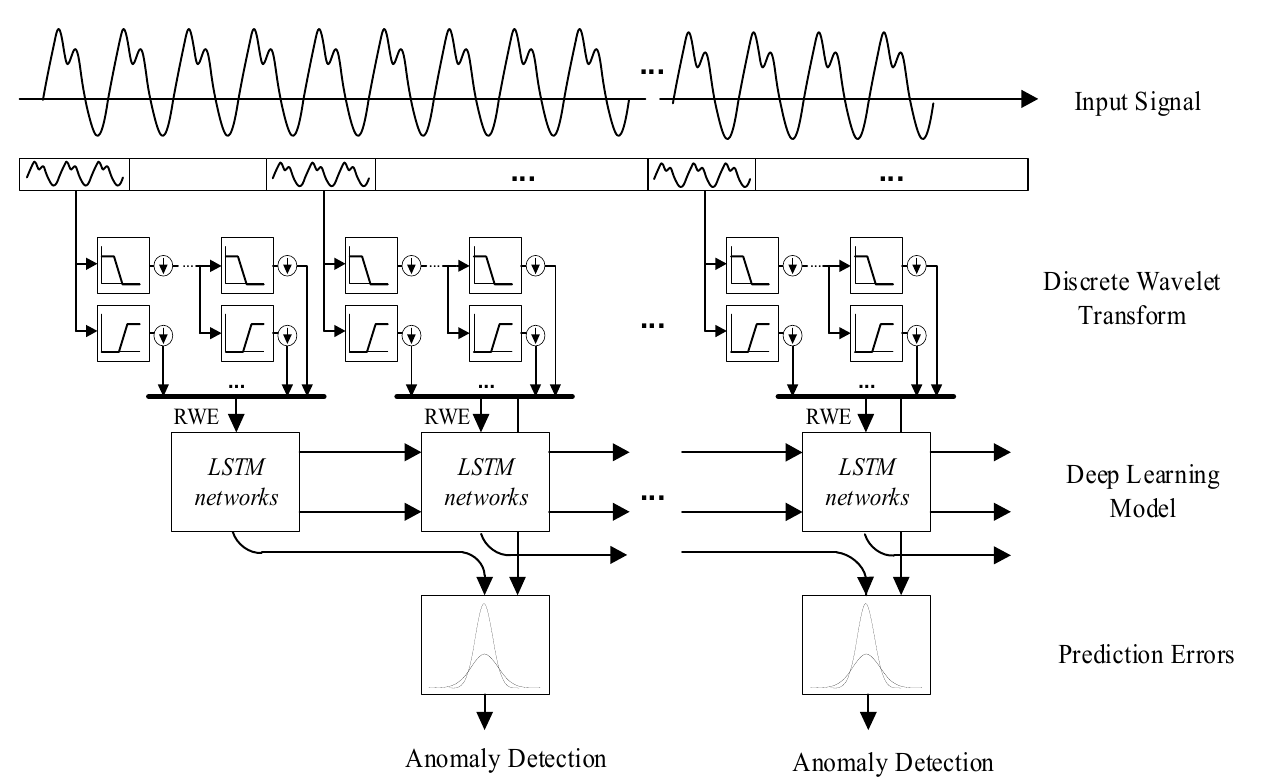
Figure 2. RWE–LSTM model-based anomaly detection algorithm.